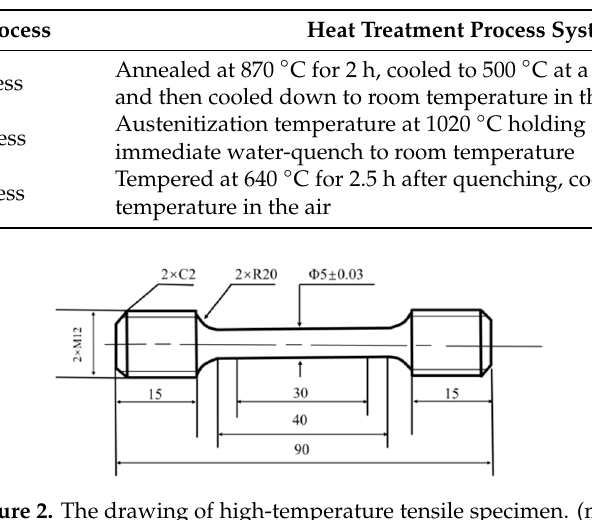
Table 3. 25Cr3Mo3NiNb steel composition (mass fraction, %). Table 4. Heat treatment process of test steels.